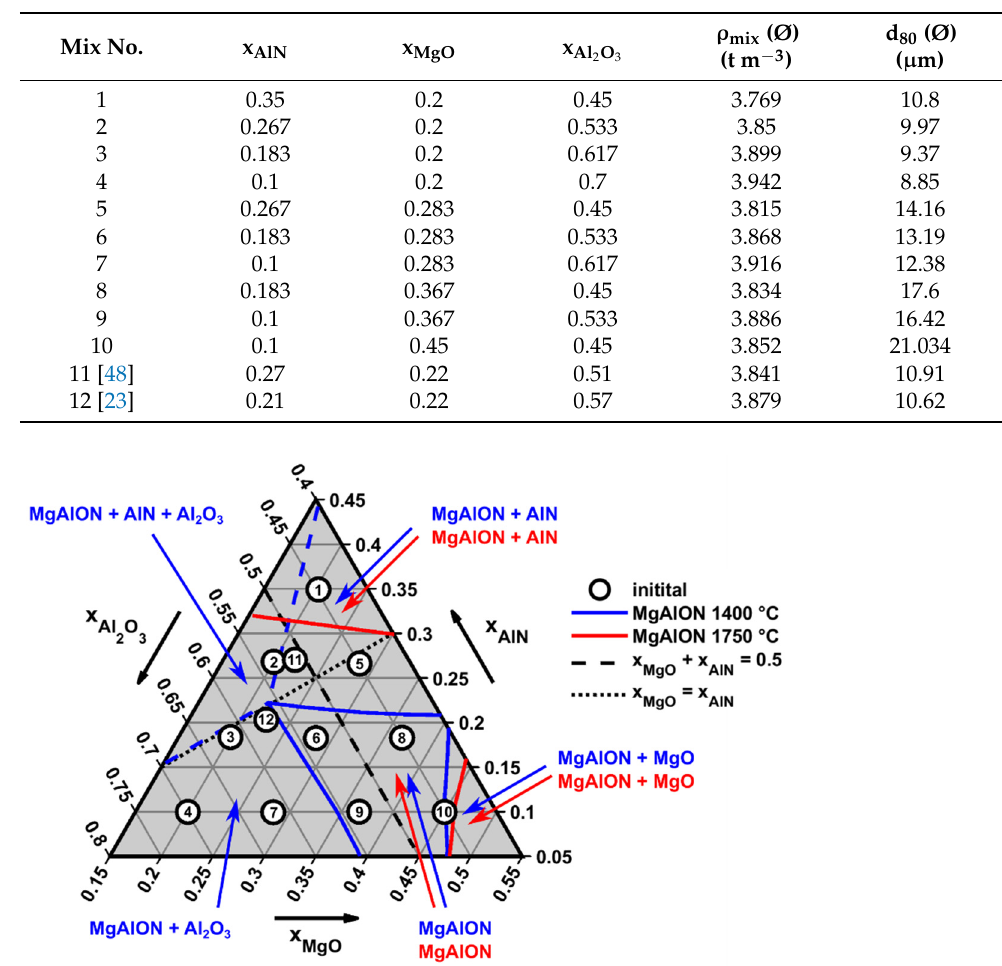
Table 3. Compositions of the powder mixtures (mole fractions of AlN, MgO, and Al 2 O 3 ) for sample manufacturing and their average densities ρ mix and particle sizes d 80 .